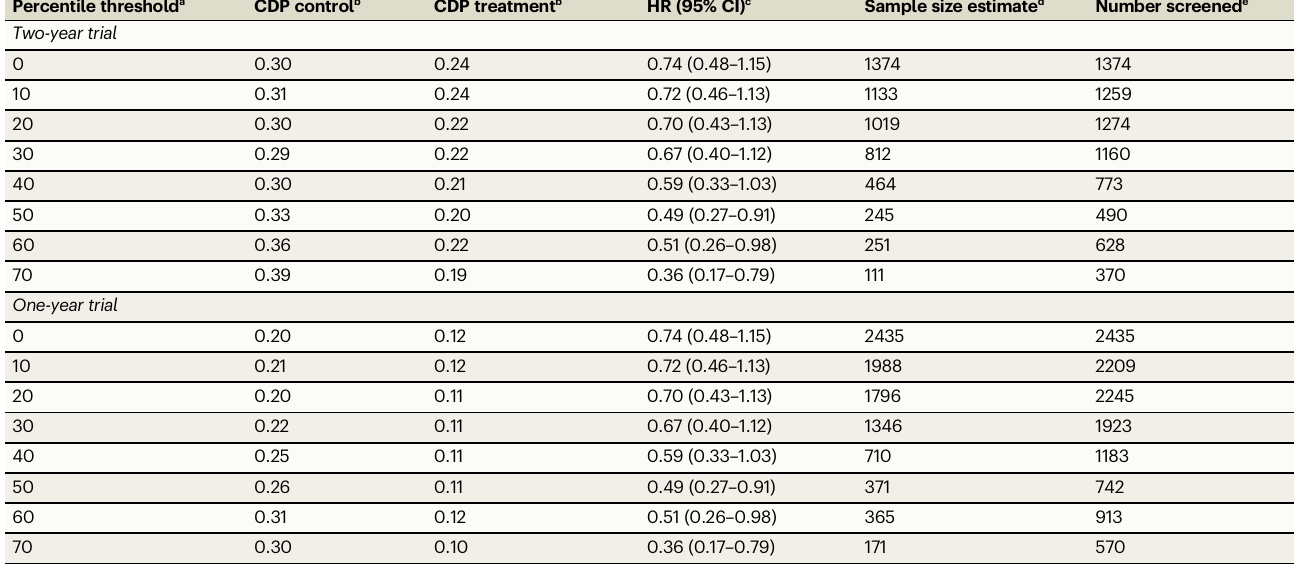
Table 4 | Estimated sample size for a one or two-year placebo-controlled randomized clinical trial of anti-CD20-Abs, using different degrees of predictive enrichment Percentile threshold